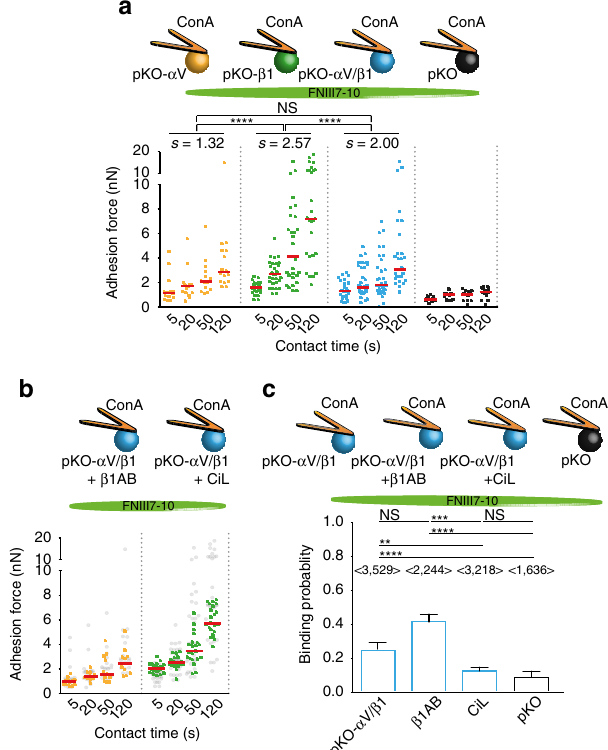
Figure 1 | Fibronectin (FN) engagement of a 5 b 1 and a V-class integrins on mouse fibroblasts. ( a ) Adhesion forces of pan-integrin knockout (pKO, black) fibroblasts rescued with either a V-class integrins (pKO- a V, yellow), or a 5 b 1 (pKO- b 1, green), or a 5 b 1 and a V-class integrins (pKO- a V/ b 1, blue). For statistical analysis, average slopes of the adhesion force over all time points were defined as adhesion strengthening and determined using a dedicated R-code (Methods and Supplementary Note 1). Statistical significant differences between the slopes ( n ¼ 100) were determined by applying two-tailed Wilcoxon tests. ( b ) Adhesion force of pKO- a V/ b 1 fibroblasts to FNIII7-10 in presence of a b 1 integrin-blocking antibody ( b 1AB) (yellow) and the specific a V-class integrin inhibitor cilengitide (CiL) (green). Adhesion forces of pKO- a V and pKO- b 1 fibroblasts (data taken from a ) are shown in light grey as reference for b 1AB and CiL experiments, respectively. Dots in a , b show adhesion forces of single fibroblasts ( n Z 10 for each condition) and red bars their median. ( c ) Binding probability of single a 5 b 1 and a V-class integrins to FNIII7-10. The binding probabilities of unperturbed pKO- a V/ b 1 fibroblasts, in the presence of b 1AB, CiL and pKO fibroblasts are shown. o n 4 equivalent to total number of force curves analysed to detect single binding event. Bars show mean and error bars the s.d. Statistical significances were calculated with two-tailed Mann–Whitney U -tests. **** P o 0.0001; *** P o 0.001; ** P o 0.01; * P o 0.05; NS, non- significant, P Z